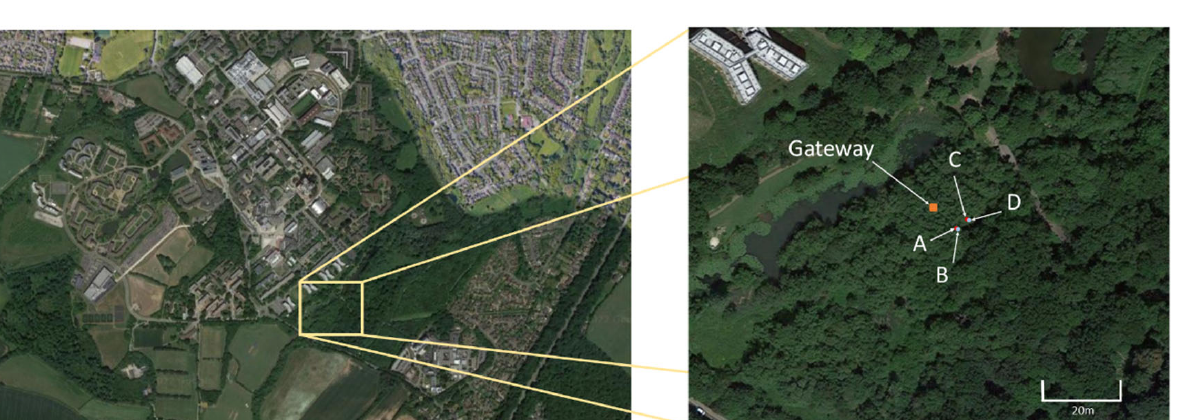
Figure 7. CO 2 probes driven to different soil depths.